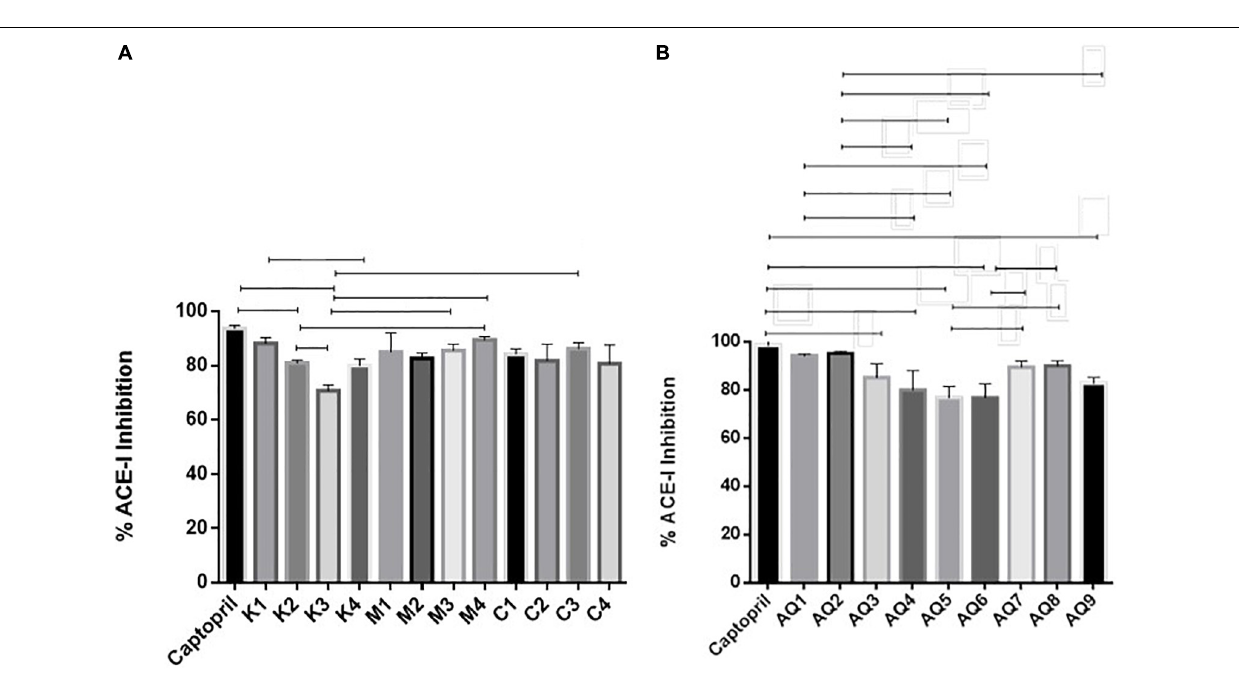
The total protein content of the mesopelagic Hydrolysates and AQ was estimated using two different methods. Initially